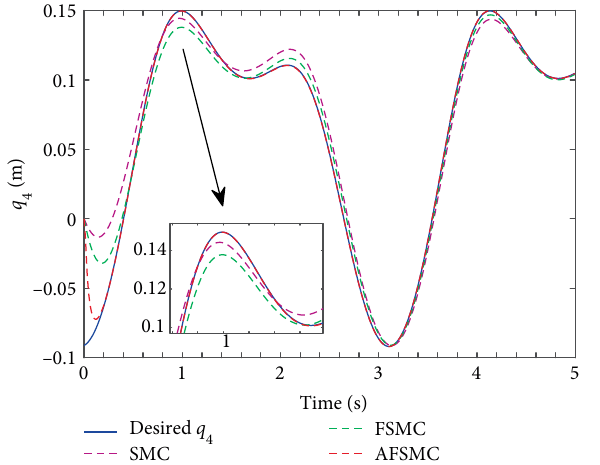
Figure 19: The tracking error with desired trajectory with rotation . angle 4 𝛽